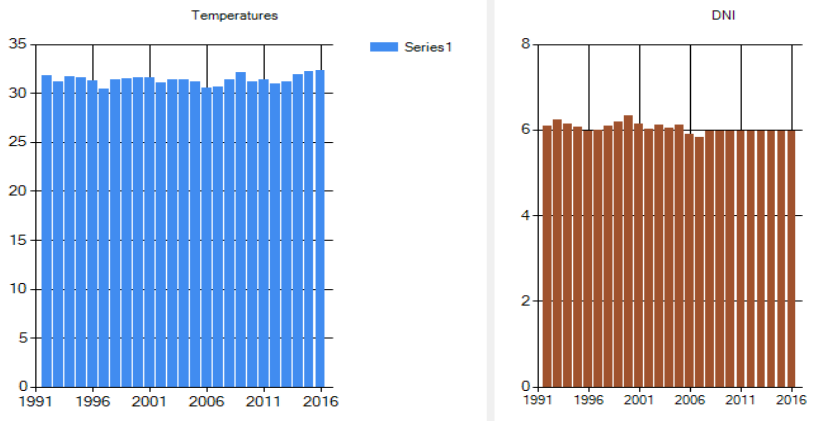
Figure 4. Temperature and DNI of Turkana using SPECA modelling